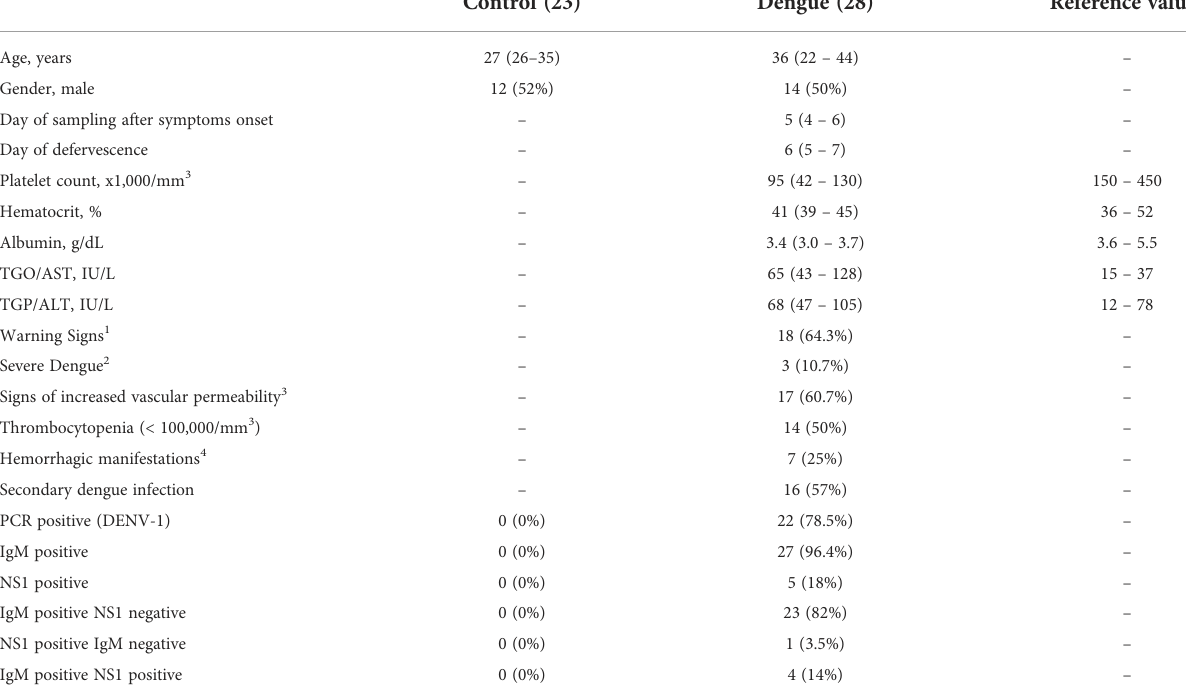
TABLE 1 Characteristics of dengue-infected patients and healthy